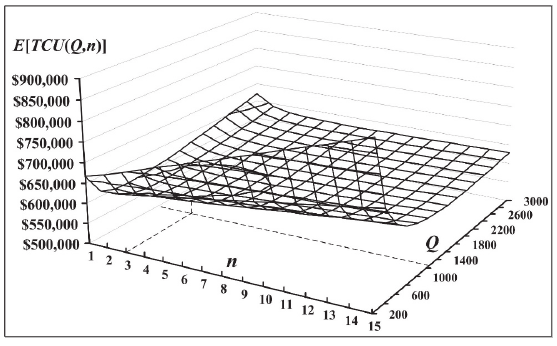
Fig. 7. Joint effects of replenishment lot size and shipments per cycle on the expected total system costs E [ TCU ( Q , n )]